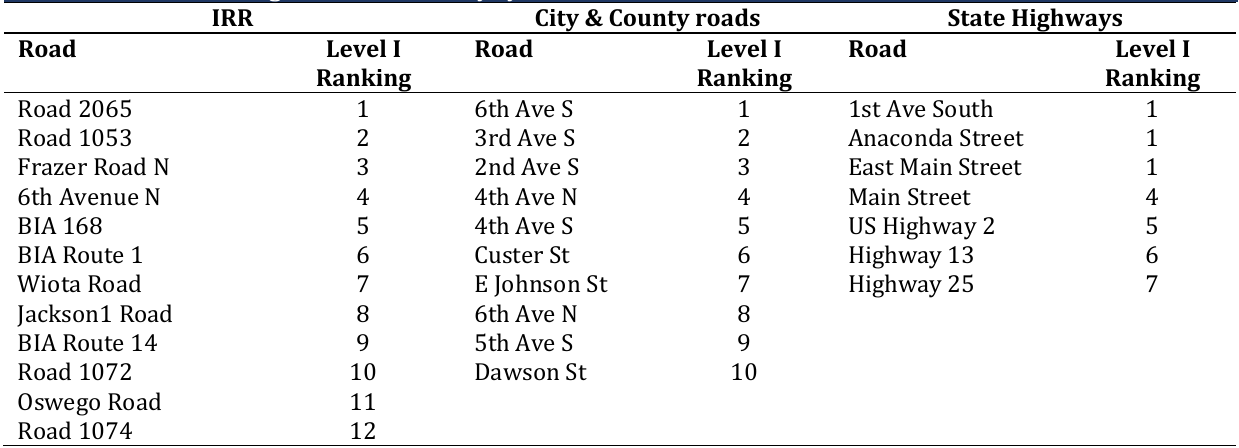
Table 2: Level I Ranking on three roadway